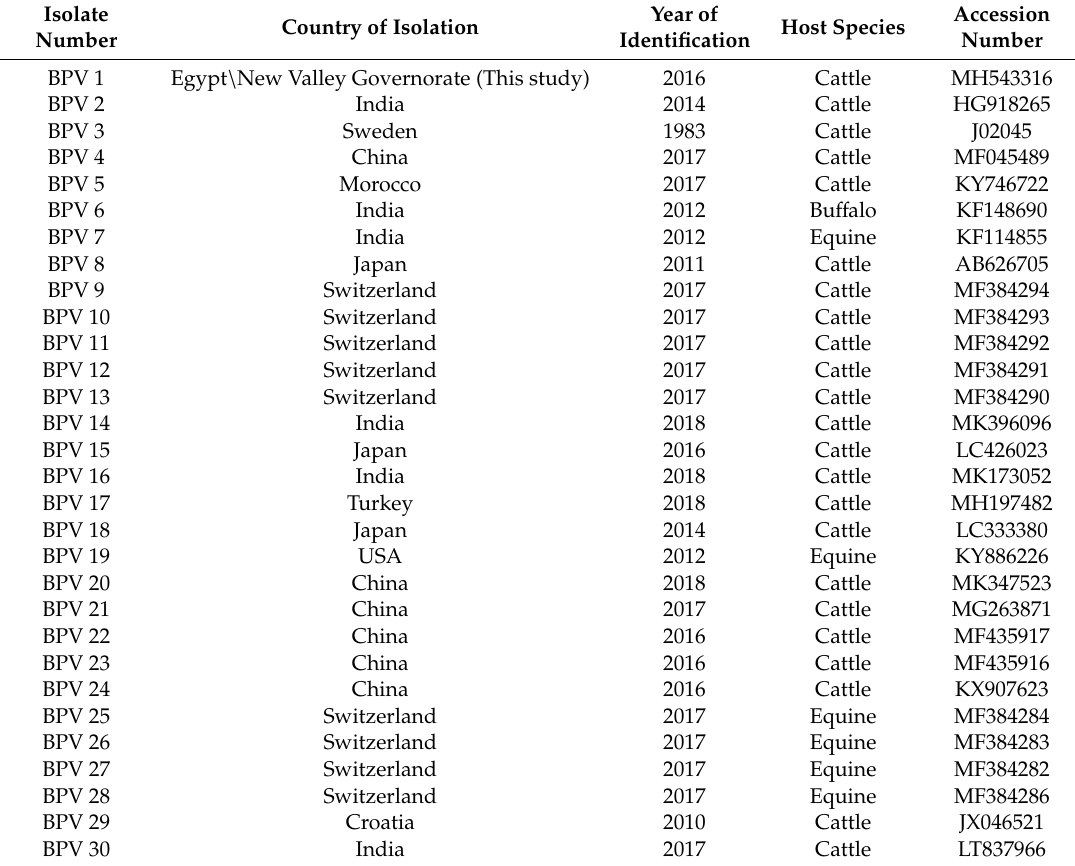
Table 2. Detailed information of L1 gene sequences of bovine papillomavirus (BPV) type-1 used in the present